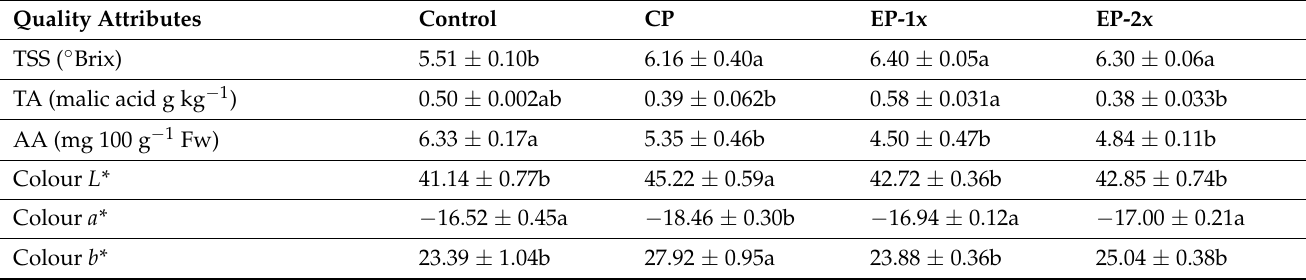
Table 3. Quality-related attributes from lettuce plants in relation to foliar application of different